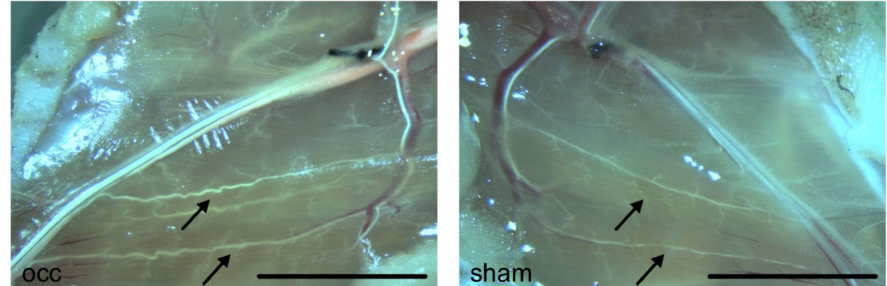
Figure 1. Photographs of superficial collateral arteries in mouse adductor muscles. Photographs were taken 7 days after induction of arteriogenesis by femoral artery ligation (left picture) or sham operation (rightpicture).Micewereperfused withlatexto bettervisualizecollateralarteries. Pre-existingcollaterals appear very fine and straight (arrows, right picture). Seven days after induction of arteriogenesis, grown collateral arteries show a typical corkscrew formation with increased vascular caliber size (arrows, left picture). Scale bar 5